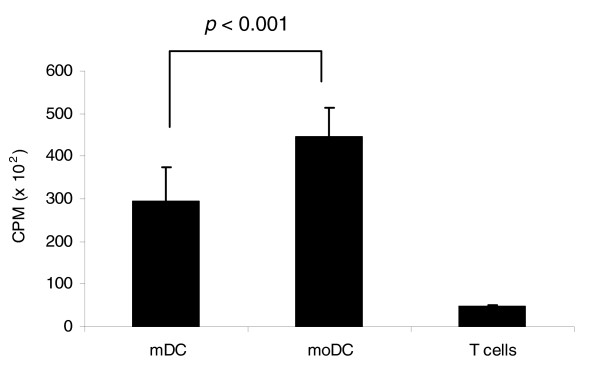
T cell activation assay. Autologous T cells were cultured in the presence of mDCs, moDCs or KG-1 cells in a 1:10 DC:T cell ratio for 3 days, followed by an 18 h pulse with [3H]thymidine. Thymidine incorporation was measured in a scintillation counter. Data represent the average of quadruplicate experiments.